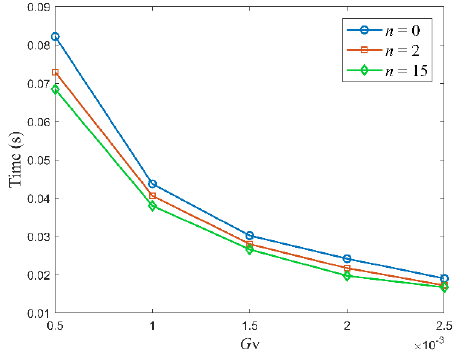
G . Figure 19. Time of vibration attenuation to the weakest with di ff erent G v v